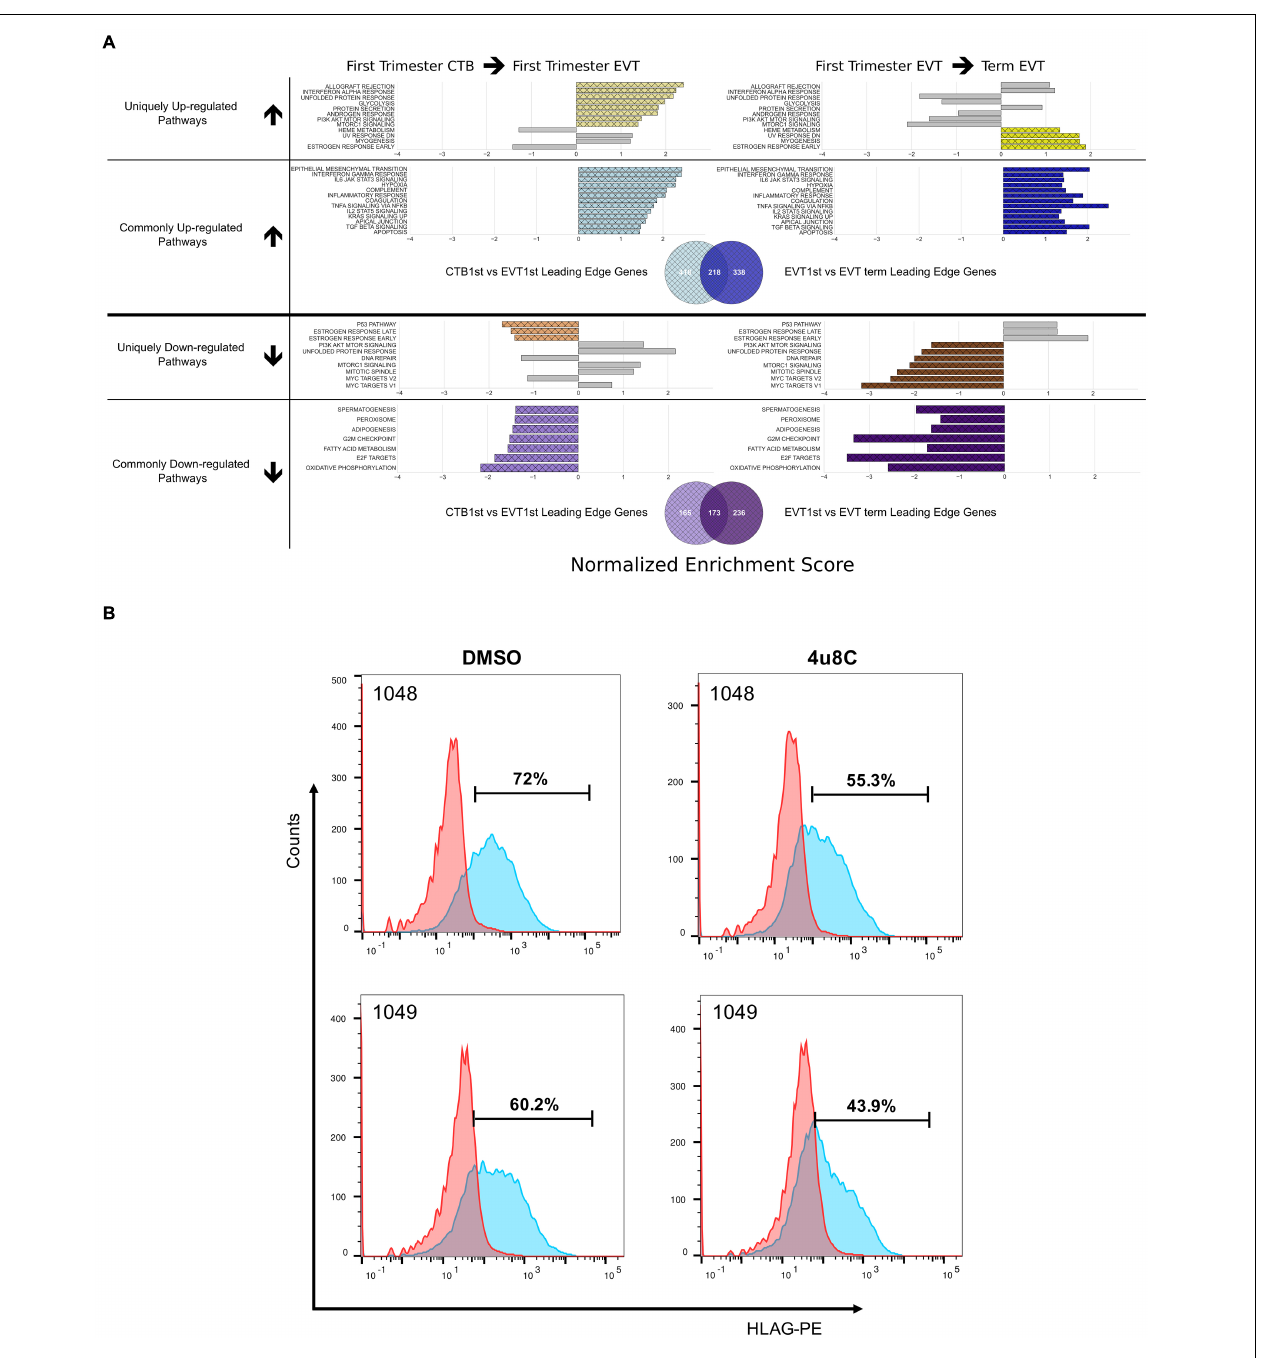
FIGURE 4 | Pathways enriched in the EVT differentiation and maturation process. (A) Pathways enriched either in one (unique) or both (common) steps of EVT differentiation (first trimester CTB → first trimester EVT) and maturation (first trimester EVT → term EVT). Colored bars in grid show significantly enriched pathways (adjusted p -value < 0.05) that are either uniquely up- or down-regulated in first trimester EVT when compared with first trimester CTB (left side) or uniquely up- or down-regulated in term EVT when compared with first trimester EVT (right side). Likewise, common up- and down-regulated pathways are shown in both comparisons. The gray bars on each unique pathway bar graphs represent the enrichment score of the comparison on the opposite side of the graph to highlight the similarity or difference of the corresponding comparison. The gray bars may show enrichment in the same direction as the colored bars; however, the pathway is considered uniquely regulated because the gray bars represent enrichment that did not achieve statistical significance. The Venn diagrams below each set of bar graphs show the number of unique and shared leading-edge genes in the commonly up-regulated or commonly down-regulated Hallmark pathways. (B) Validation of the IRE1-alpha arm of the unfolded protein response (UPR) pathway regulating surface HLA-G expression in EVT. Two hTSC lines were differentiated to EVT in vitro in the presence of either the IRE1-alpha inhibitor, 4u8c, or DMSO carrier alone. Graph shows the percentage of HLA-G + cells at the end of the 5-day treatment, with ∼ 25% decrease in these cells in the presence of the